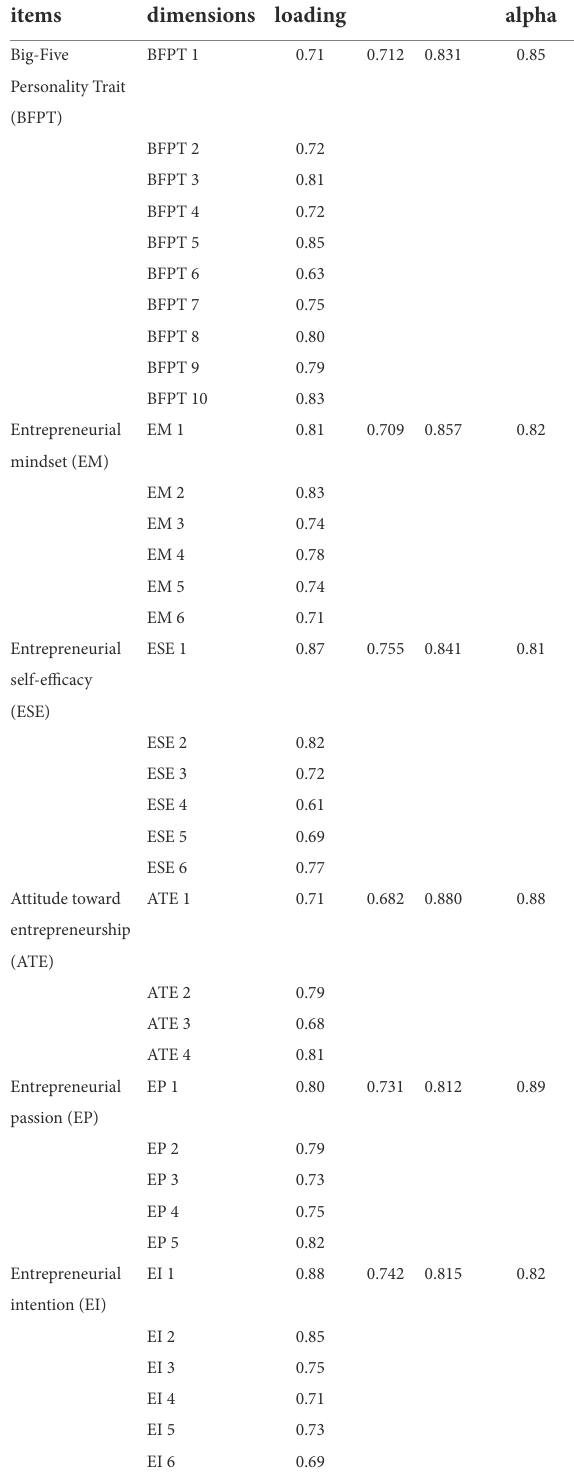
TABLE 2 Evaluation of the measurement